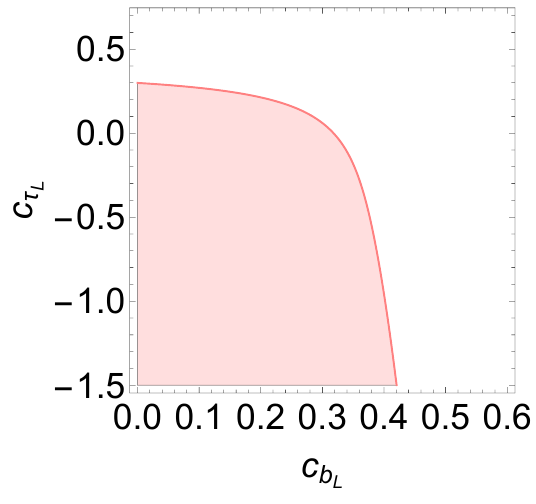
Figure 19 . Region at 2 (cid:27) in the plane ( c b (white region) as shown in eq.